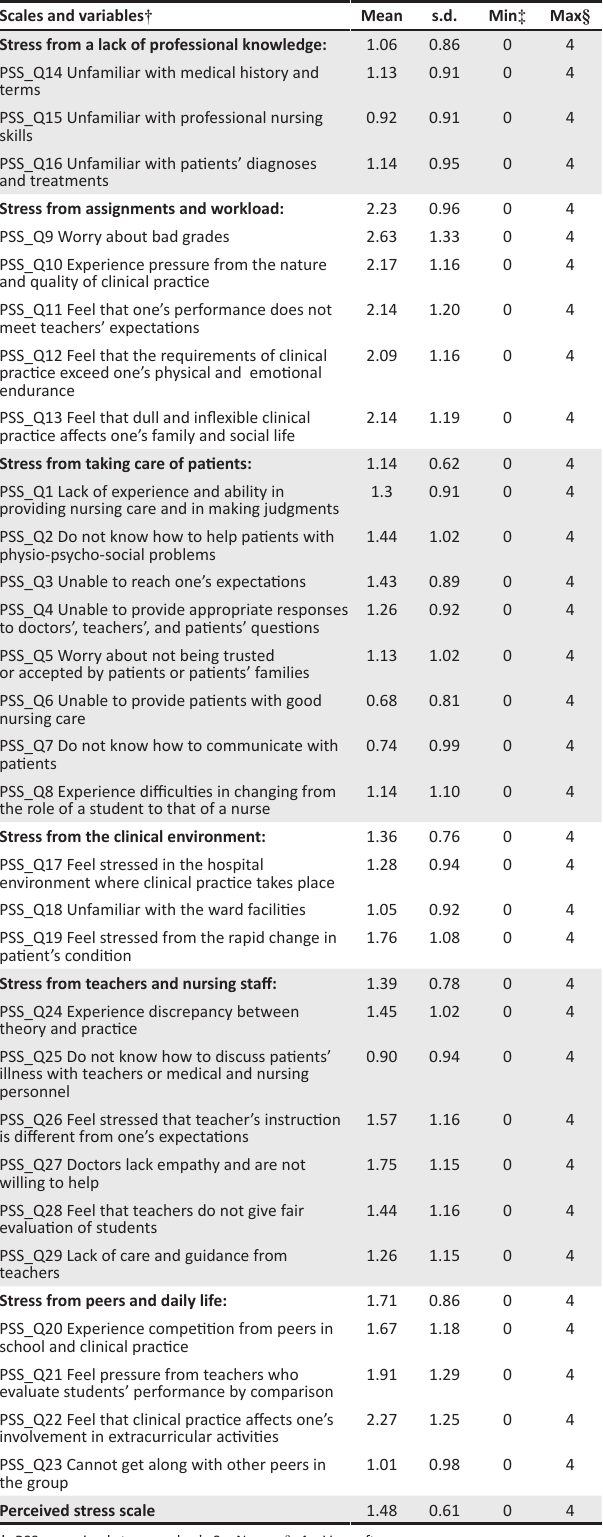
TABLE 5: Factor loadings. Latent factor (stress from) *